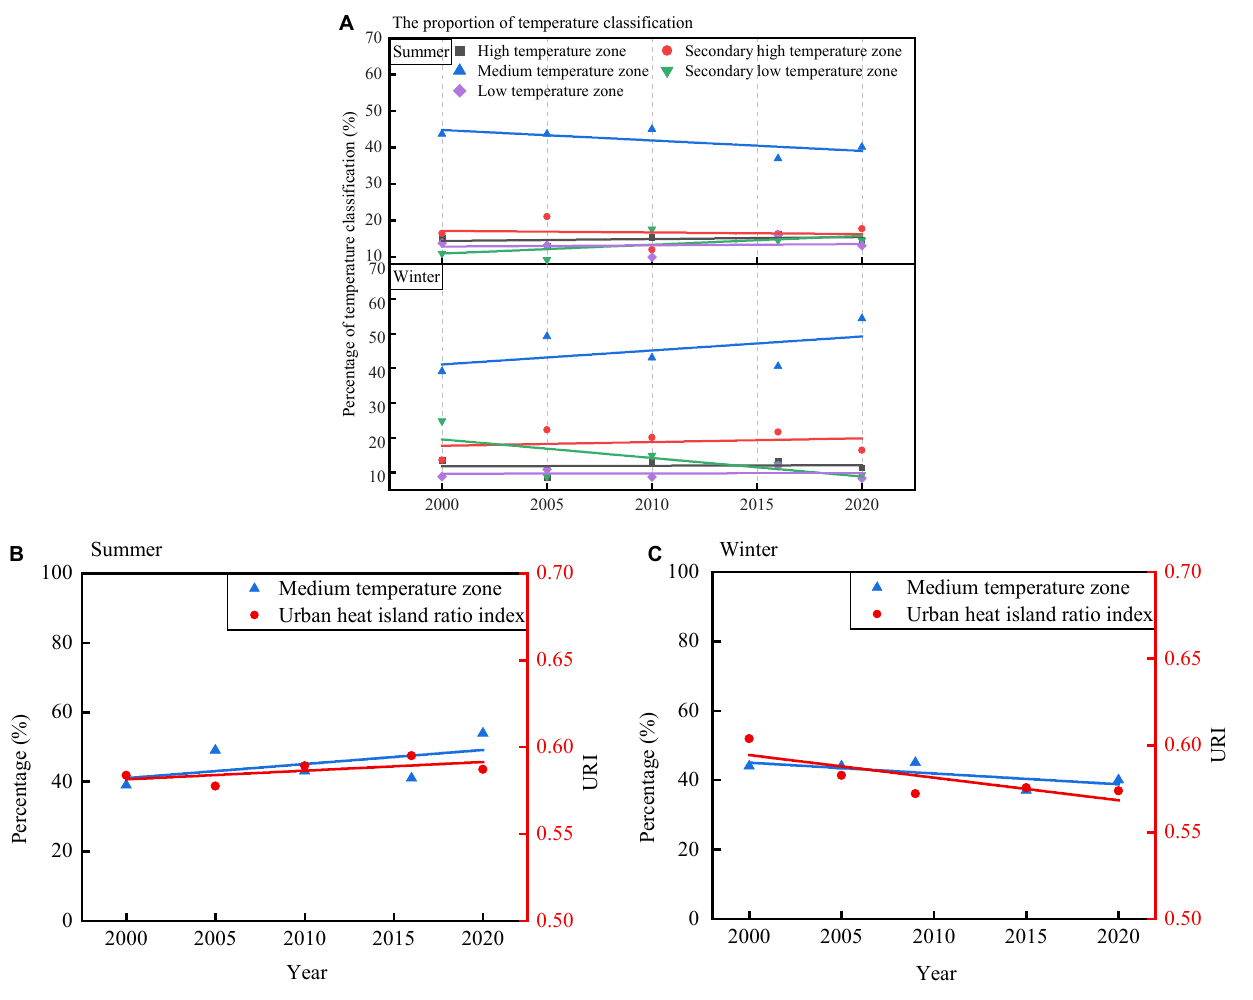
Frontiers in Plant Science |